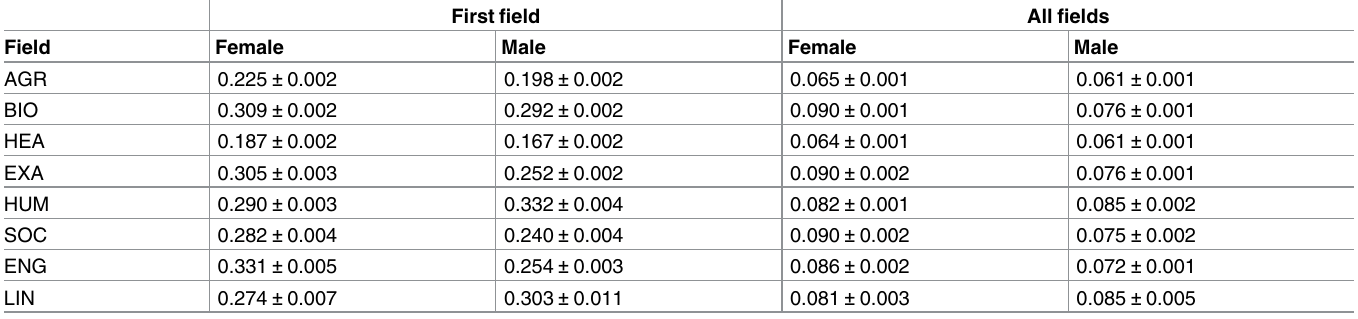
Table 4. Average m-ratio for men and women for the eight major fields. The first two columns are obtainedfrom Eq (2), where the sum in the numerator is over all co-authors with different major field, while, for the last two is over all co-authors without any field in common. Same abreviations for the fields as in Table